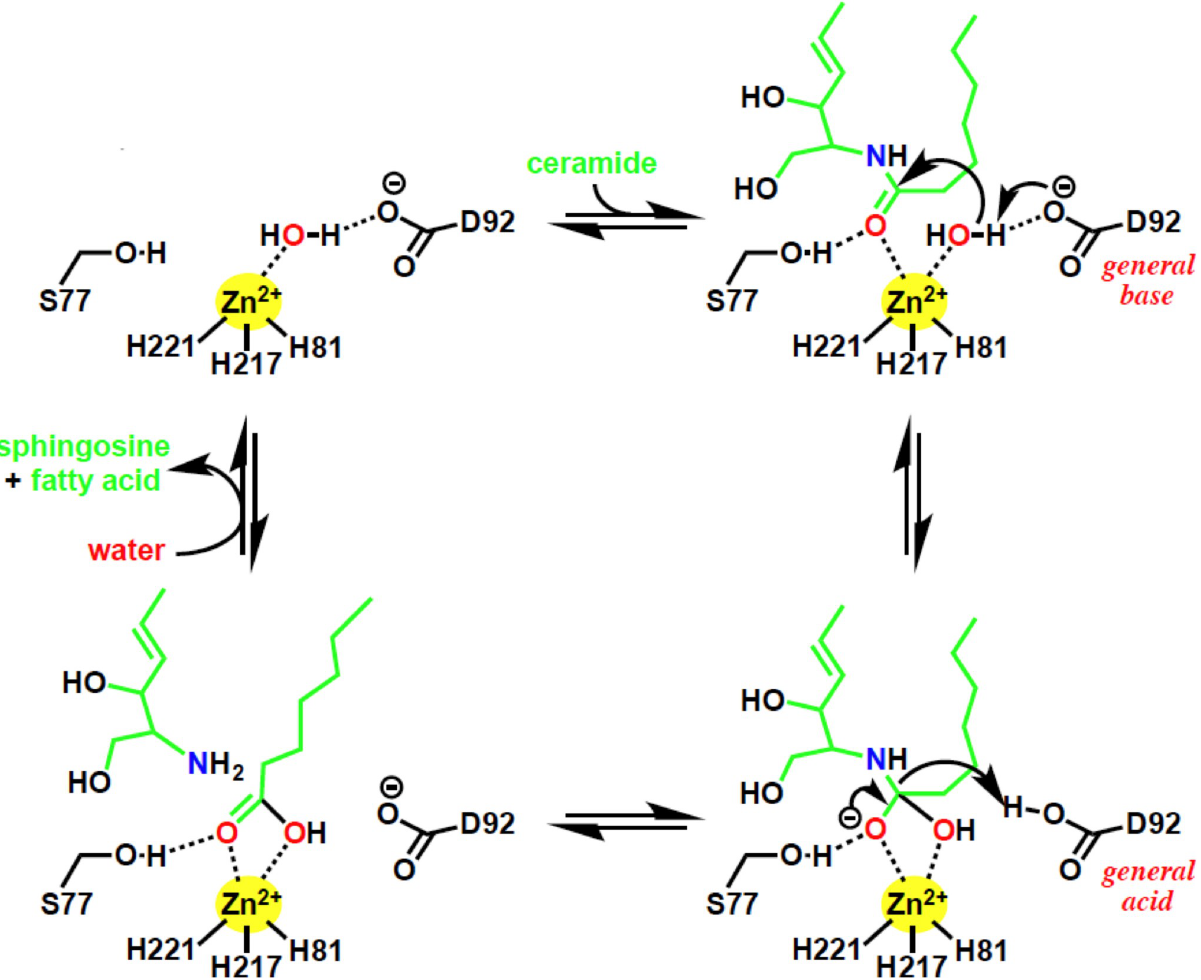
Fig 5. Suggested ACER3 catalytic mechanism. The bottom right panel, tetrahedral transition